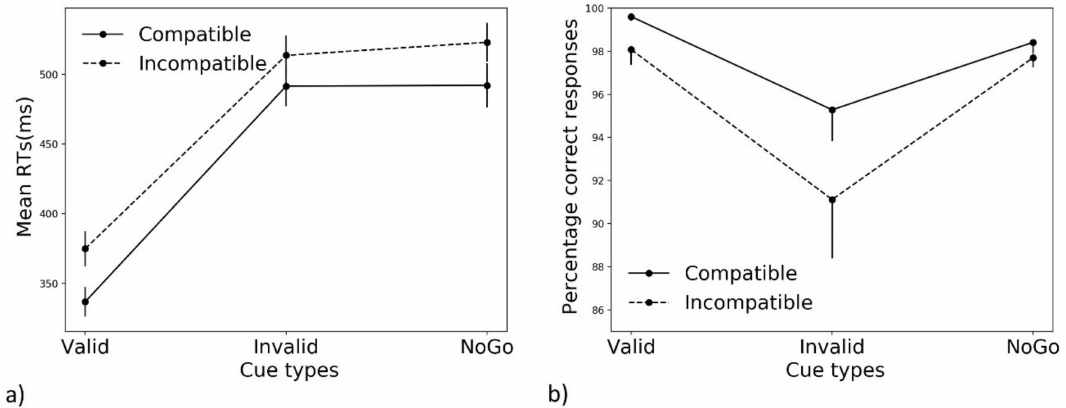
Figure 2. Average RTs ( a ) and percentage of correct responses ( b ) are displayed separately for compatible (filled line) and incompatible (dashed line) trials, and for each cueing condition. Error bars represent the standard